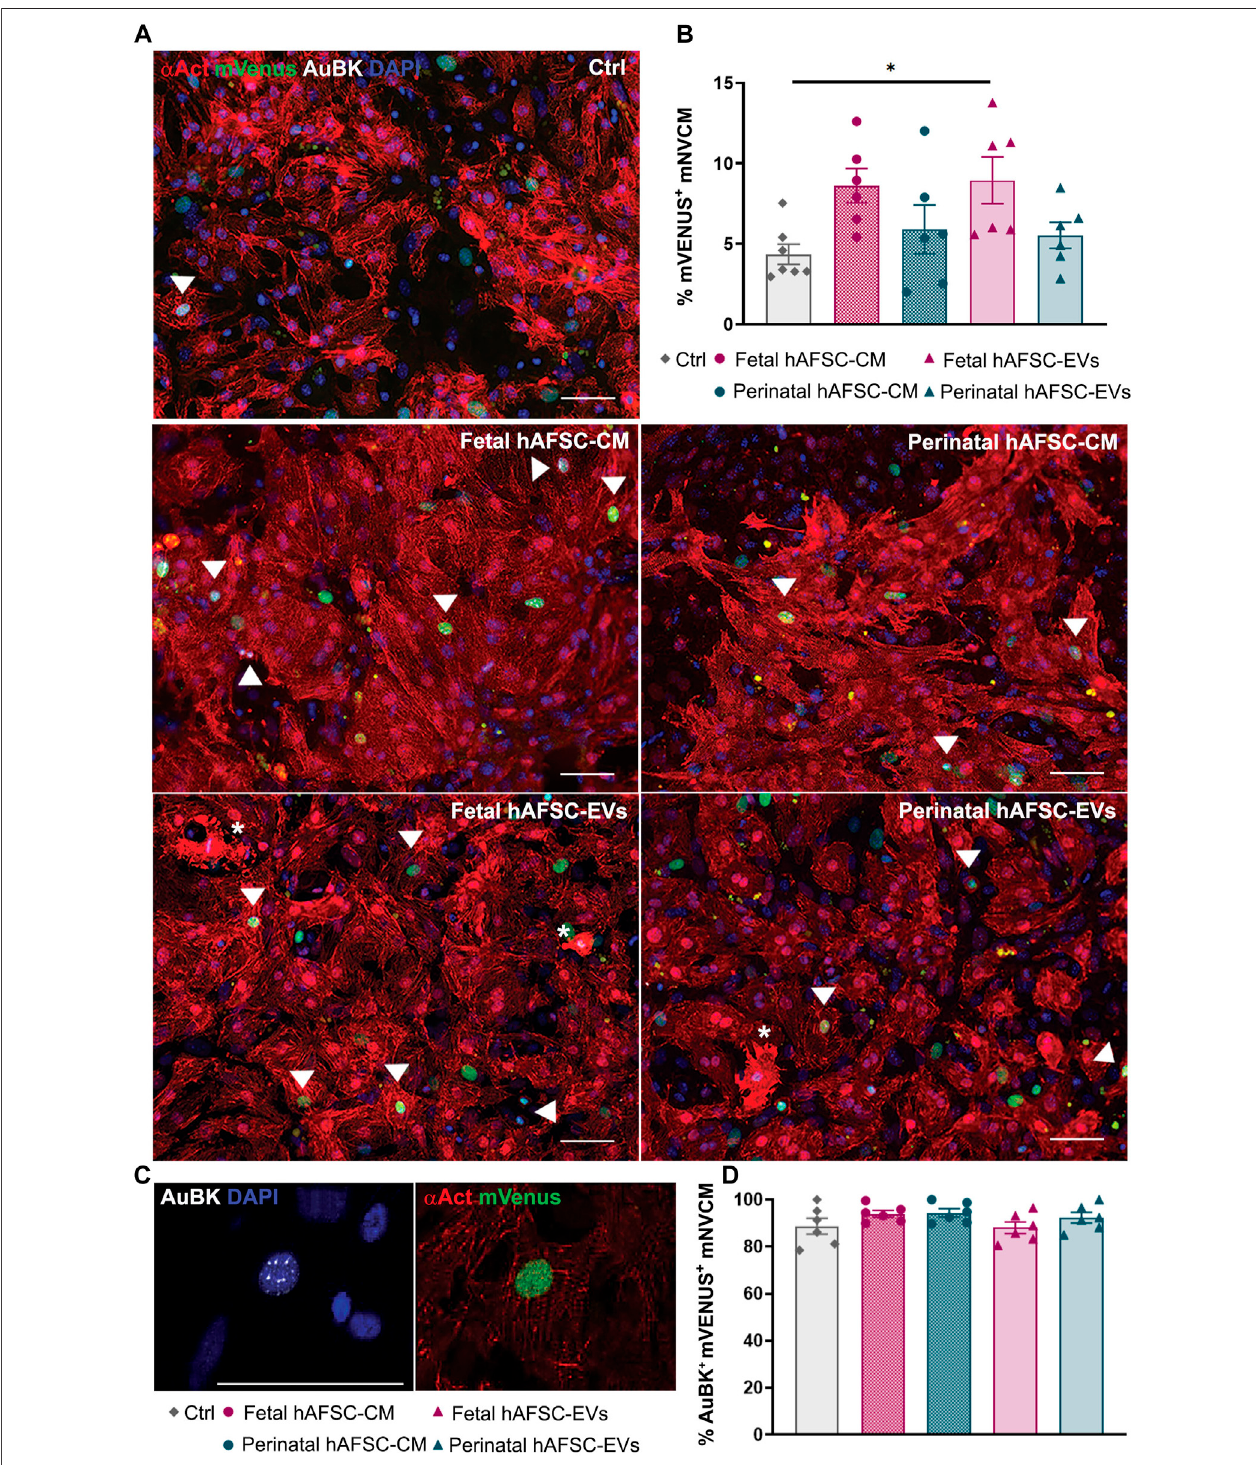
FIGURE 1 | In vitro mNVCM cell cycle re-entry following stimulation by fetal versus perinatal hAFSC secretome formulations. (A) Representative images of R26pFUCCI2 +/ − mNVCM in vehicle-treated control conditions (SF medium, Ctrl) or following treatment with fetal or perinatal hAFSC-CM or hAFSC-EVs by immunostaining for sarcomeric alpha-actinin ( α Act, red), mVenus-Geminin (mVenus, green), Aurora B kinase (AuBK, white), and DAPI (blue), scale bar: 50 µm. White arrows point at α Act-positive cells (mNVCM) with mVenus nuclear signal; white asterisks indicate mNVCM with disarranged α -actinin expression as sarcomeric disassemblyfeature. (B) AnalysisofmVenus-positiveand α Act-positivecells(mVenus + mNVCM)expressing α ActcellsfollowingstimulationwithfetalorperinatalhAFSC